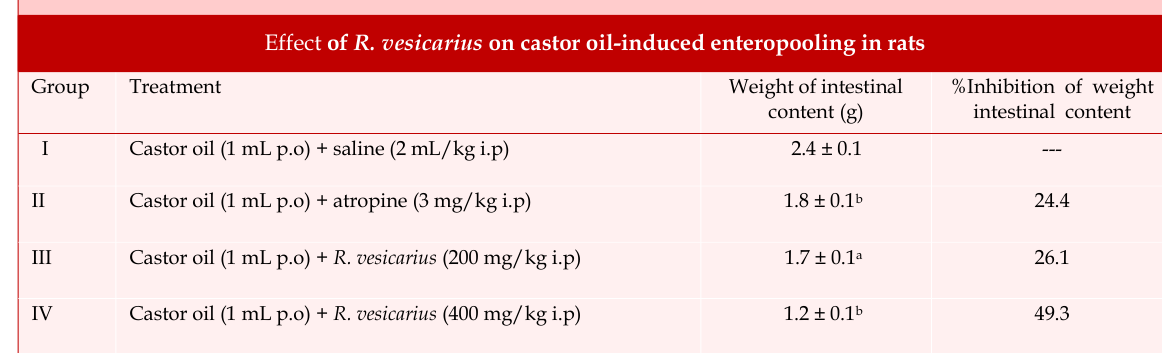
Effect of R. vesicarius on castor oil-induced enteropooling in